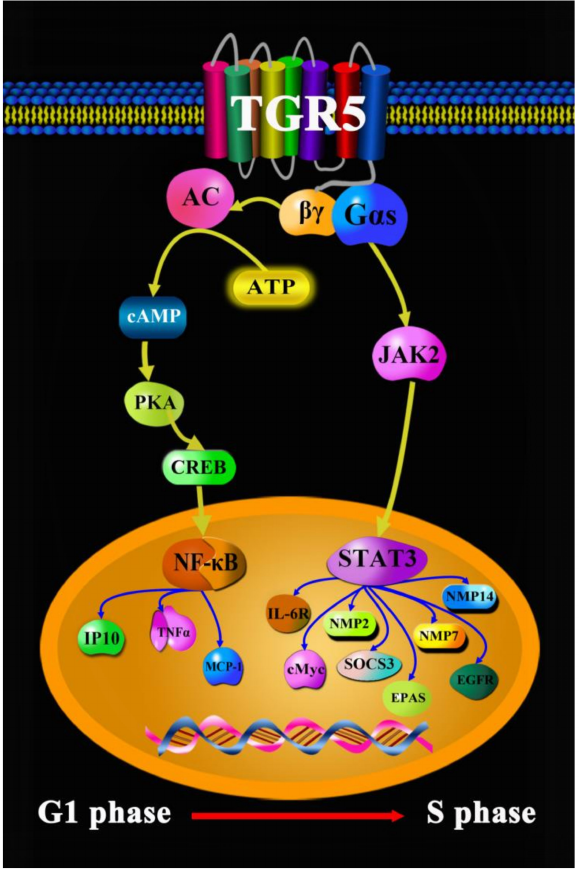
Figure 5. TGR5 in gastric